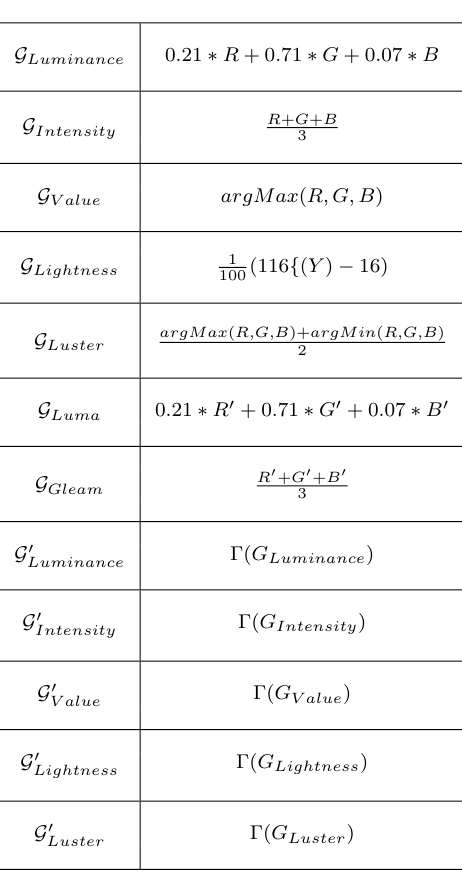
TABLE I C OLOR - TO - GRAYSCALE A